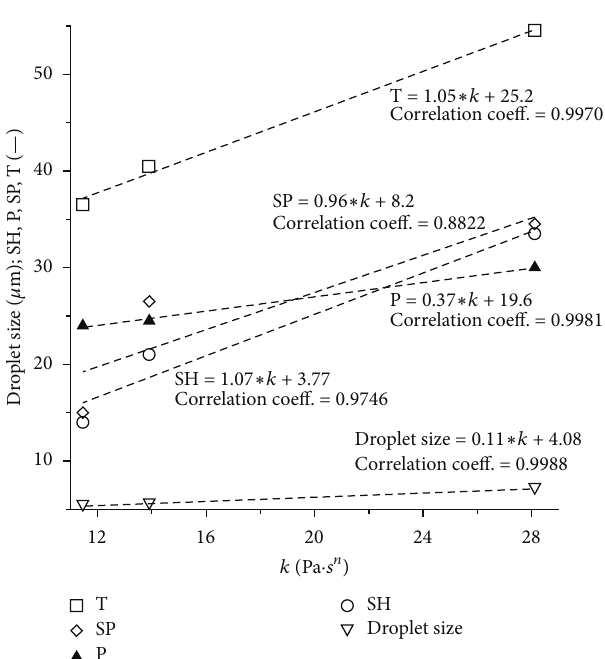
Figure 5: Relationship between sensory parameters (and droplet size) and flow behaviour index 𝑛